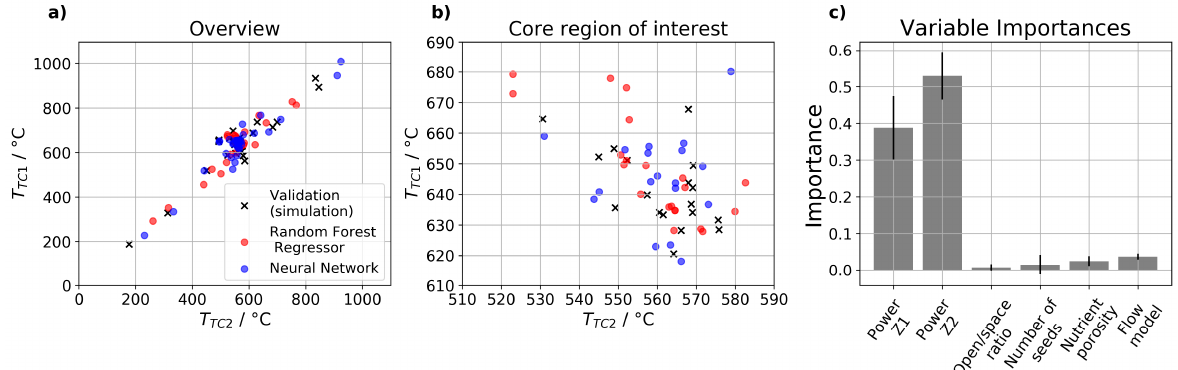
Figure 5. Results using the complete dataset at the end of this study. ( a ) Overview of simulated data together with those predicted by the random forest regressor and neural network, ( b ) close-up of the temperature region of interest, ( c ) feature importances obtained from the random forest regressor model (error bars represent inter-trees variability).